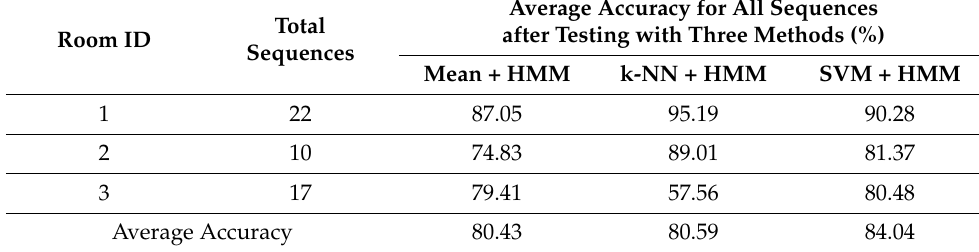
Table 5. Comparison of three methods.